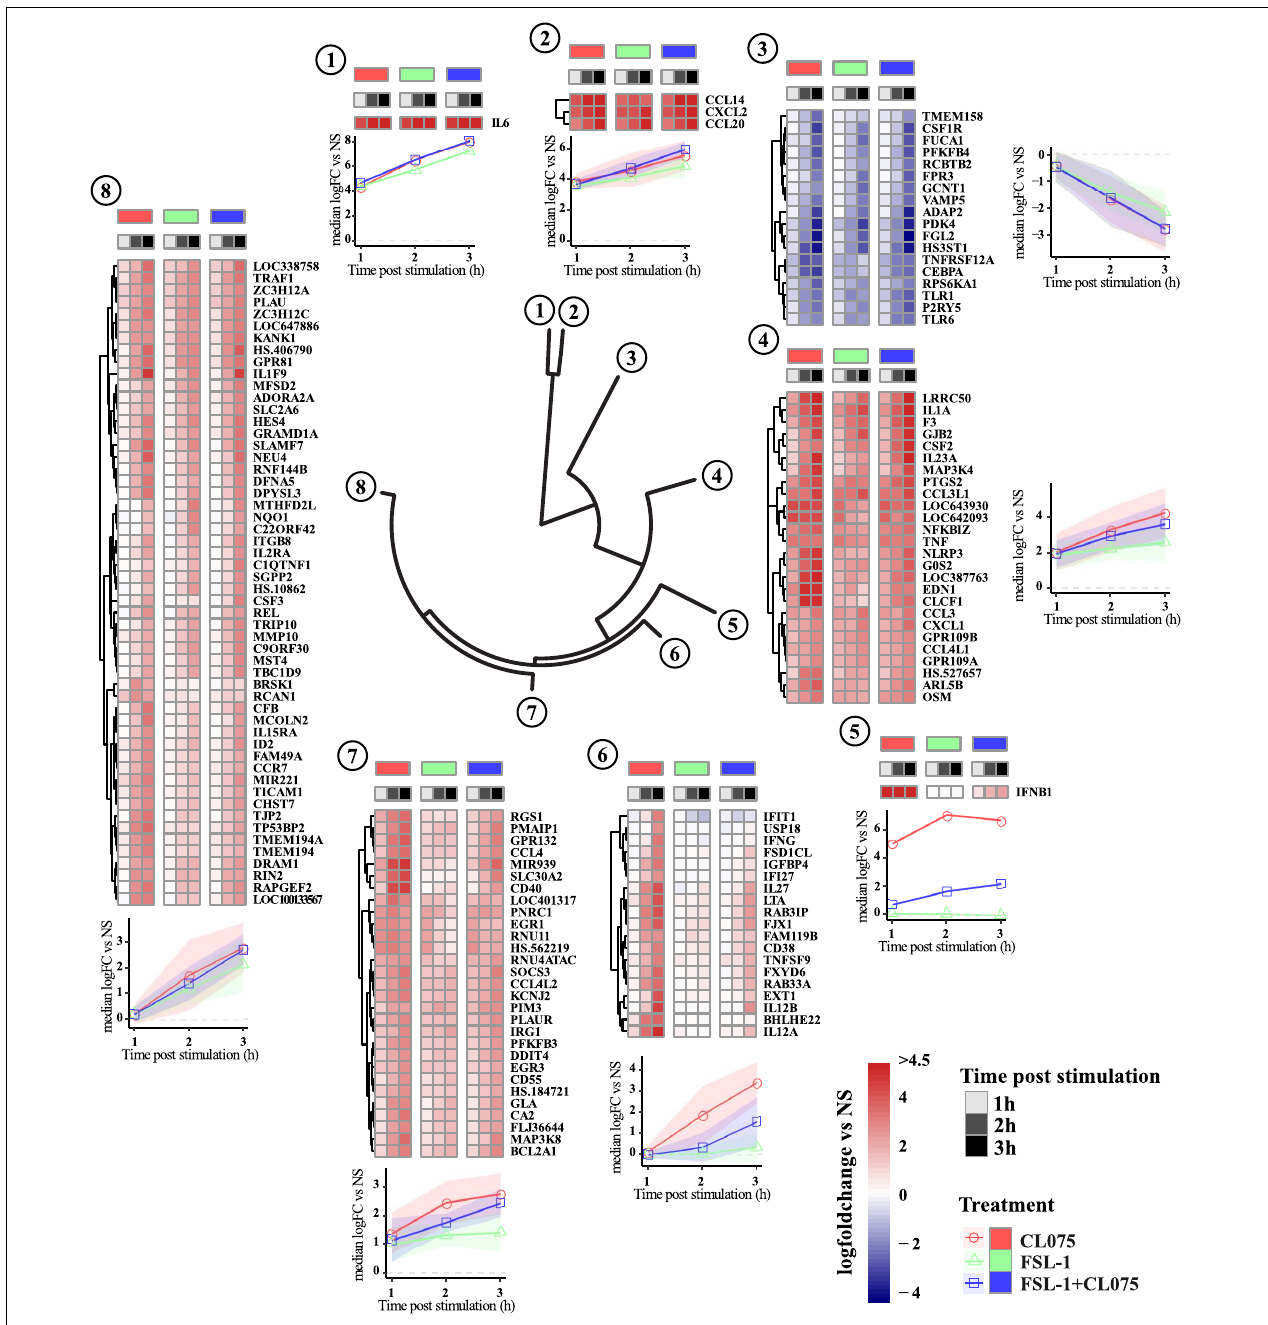
FIGURE 2 | Clustering and magnitude of differentially regulated genes in monocytes. Gene transcript expression changes compared to non-stimulated samples were calculated as log fold change and hierarchical clustered using Manhattan distance matrix calculation and divided into 8 clusters. Clustering of the dataset positions IFN β in a separate cluster. Genes in cluster 6–8 are induced later than genes in cluster 1, 2, and 4. Cluster 6 shows a clear pattern of being dominated by TLR8 stimulation with expression of several genes described as IFN-induced genes significantly reduced by co-stimulation. Overall TLR8 clearly induces a stronger response than TLR2, again with co-stimulation falling between the two responses